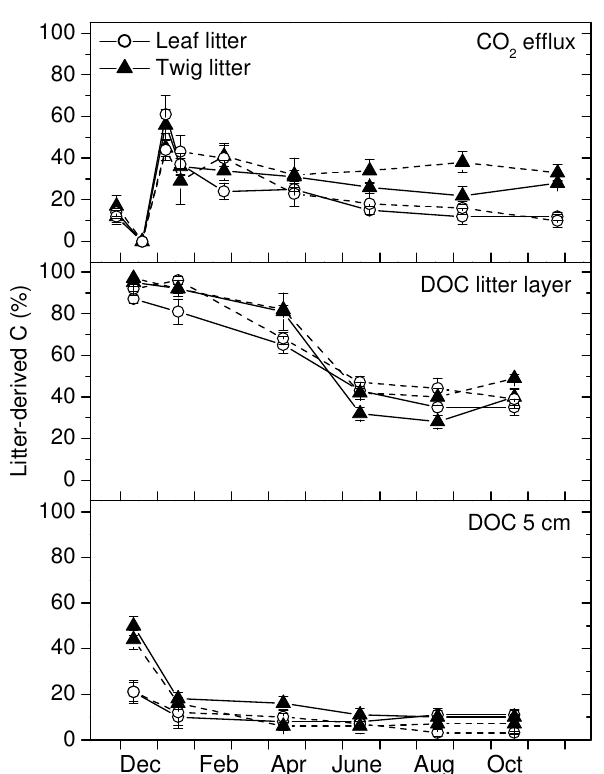
Fig. 4. Contribution of litter-derived C to the soil CO 2 effluxes and to the DOC leached from the litter layer and from the mineral soil at a depth of 5cm. Means and standard errors of five replicates in the Rendzina (solid line) and the Cambisol (dashed line).